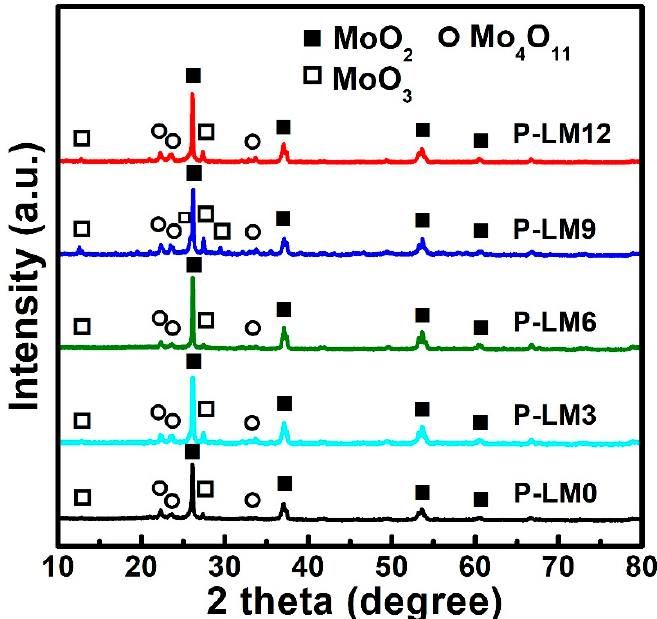
Figure 3. XRD patterns of MoO 2 precursors doped with different La 2 O 3 content and synthesized by